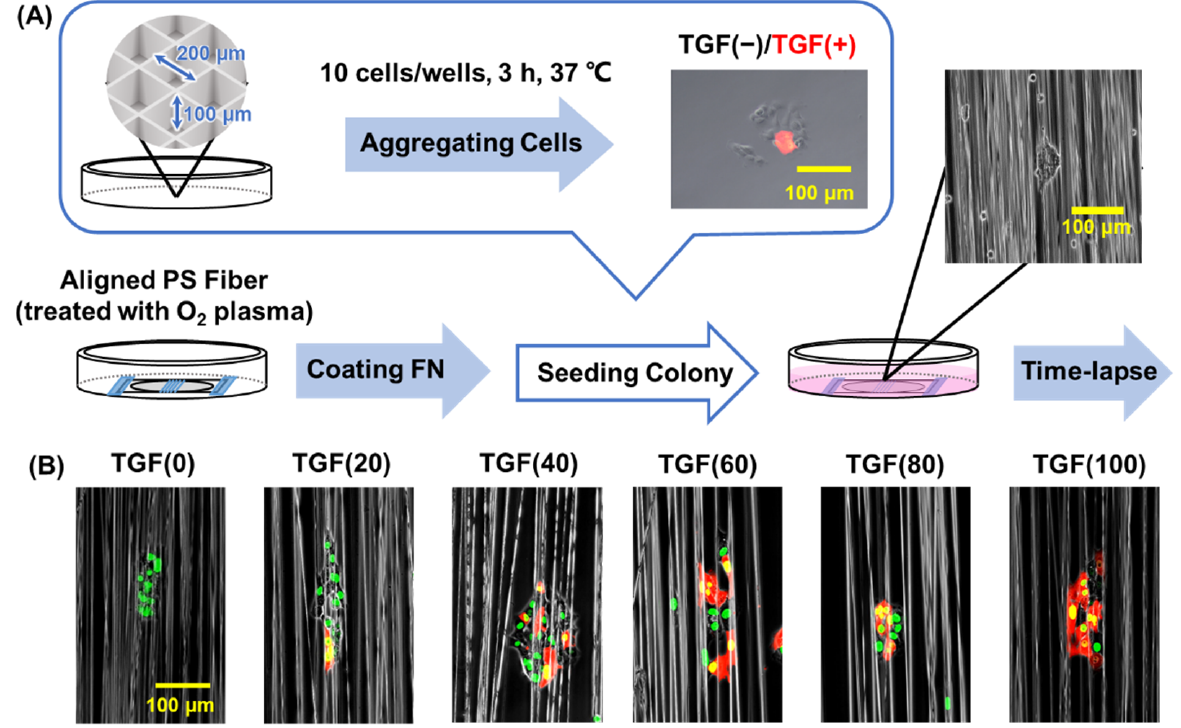
Figure 1. Experimental procedure. ( A ) Schematic diagram of the preparation of cell aggregate and seeding onto aligned polystyrene (PS) fibers. ( B ) Aggregates of transforming growth factor (TGF) (+) cells (red) and TGF ( − ) cells (green) were inoculated onto the fi bers.